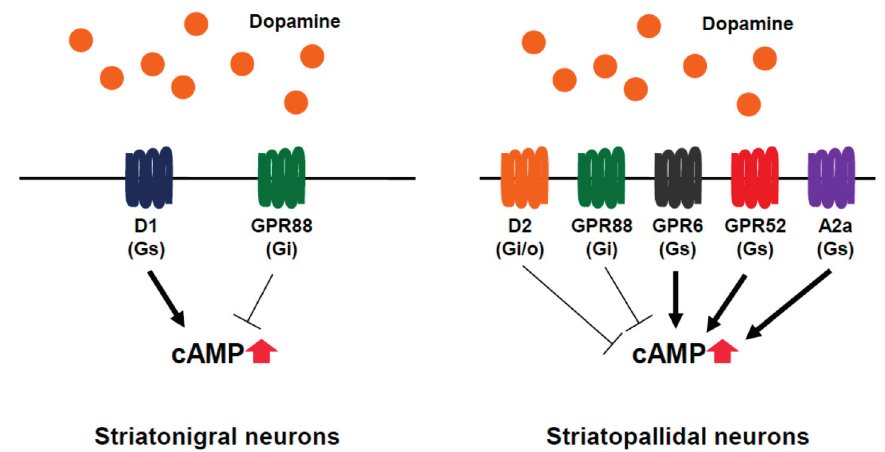
Figure 1. Striatal-enriched GPCRs in medium-sized spiny neurons (MSNs) in striatum. MSNs can be divided into two types of neurons: striatonigral ( left ) and striatopallidal MSNs ( right ). Gs-coupled receptors including D1, GPR52, GPR6, and A2a receptors raise intracellular cAMP concentration which can be reduced by Gi/o-coupled receptors including D2 and